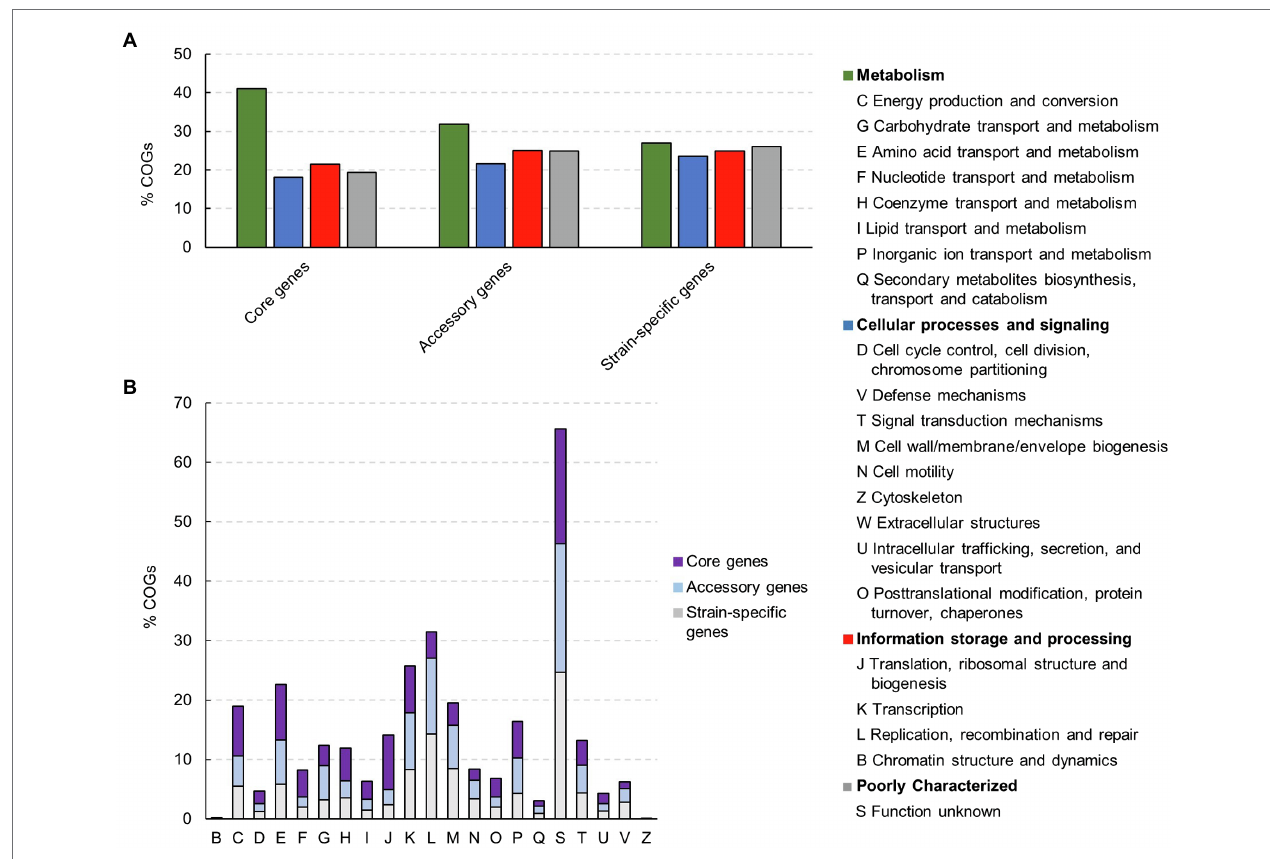
FIGURE 4 | Clusters of orthologous groups (COGs) in core- and accessory genome, and strain-specific genes and their associated functions in 28 Clostridium tyrobutyricum genomes. (A) Distribution of functional COGs in each core, accessory, and unique genome. (B) Detailed distribution of COGs with their